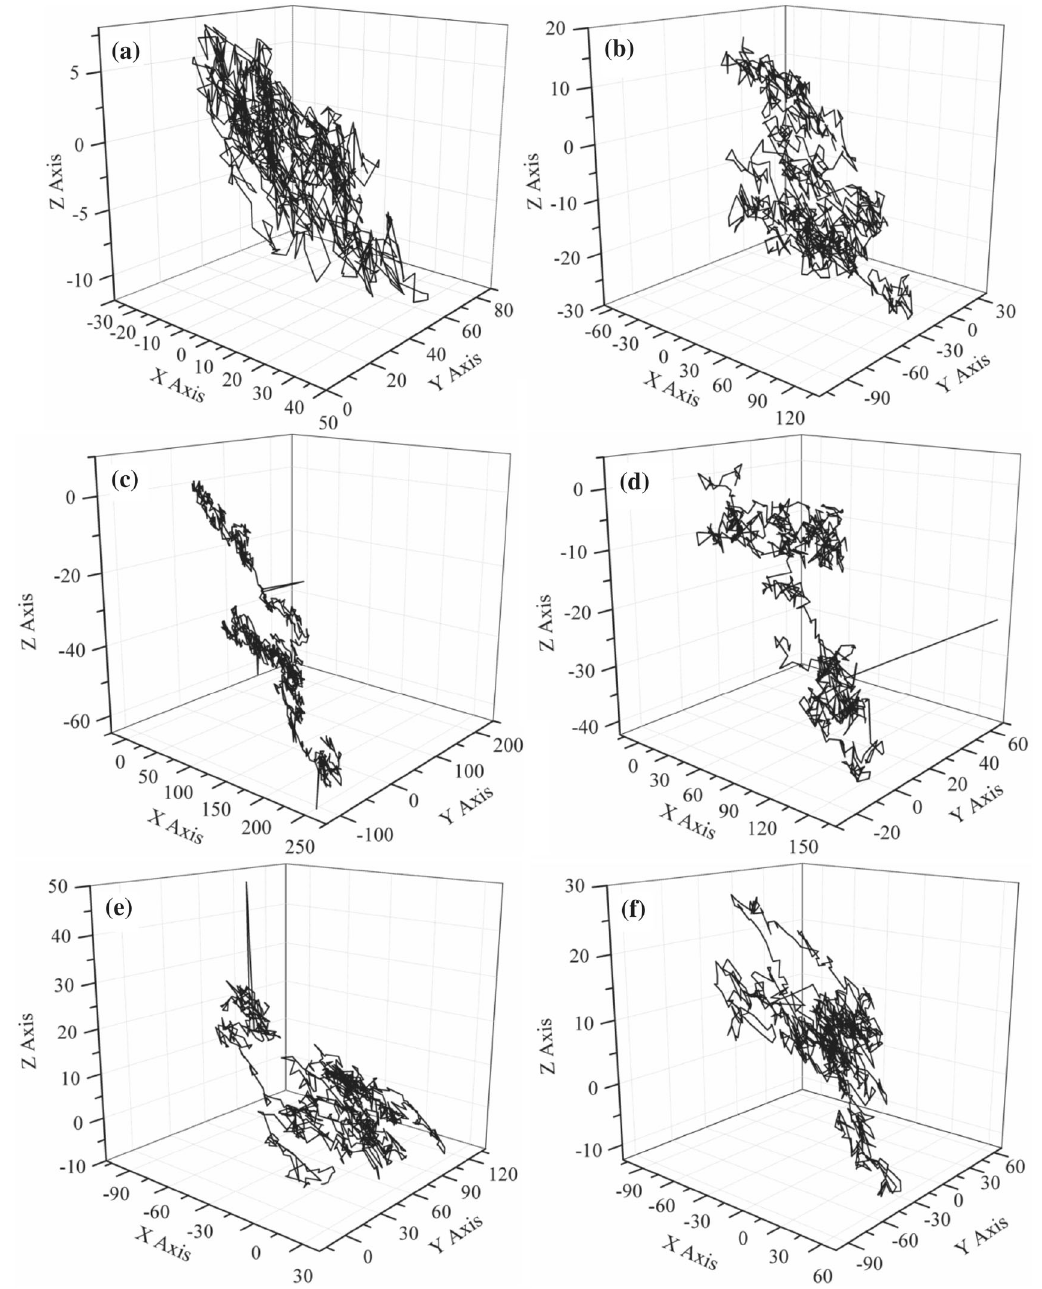
Fig. 4 Diffusion pathway of a CH 4 molecule in kaolinite matrix with a 0%, b 1%, c 2%, d 3%, e 4%, and f 5% water contents during a time period of 1000